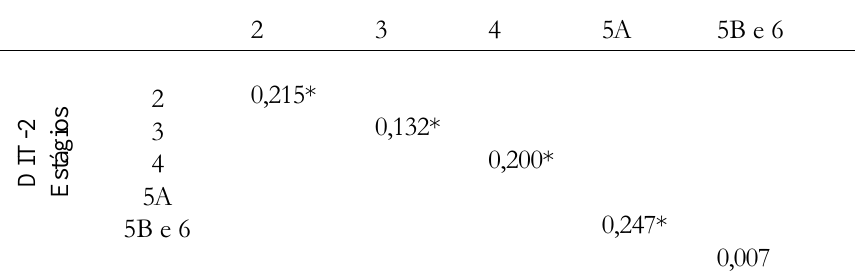
Apresentaremos, primeiramente, os cÆlculos